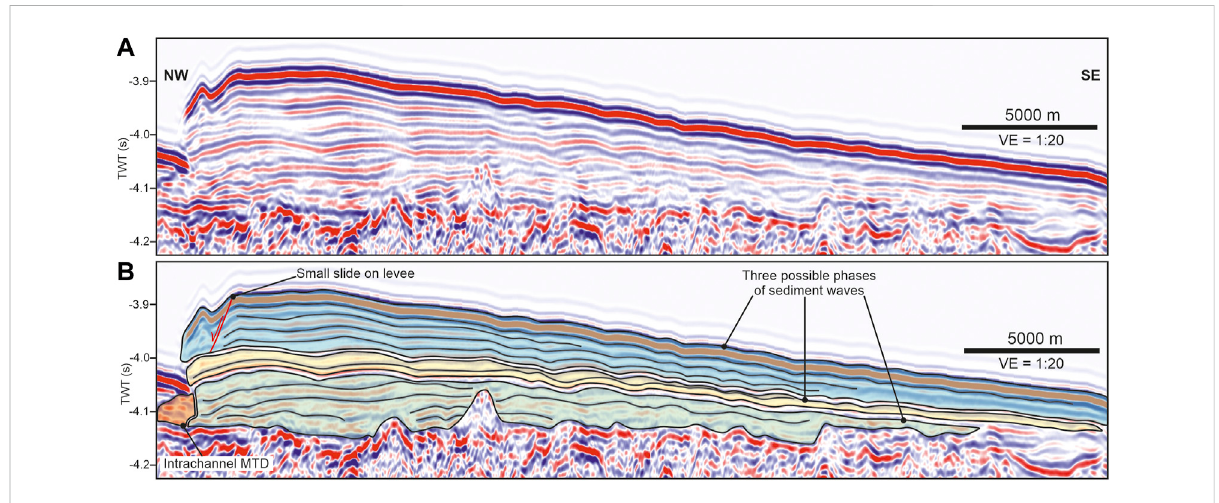
FIGURE 8 Seismic re fl ection cross-section showing extensive, asymmetric sediment waves on the eastern levee of C3 (C3 (A) in Table 2), with (B) and without (A) interpretation. For fi gure location, see Figure